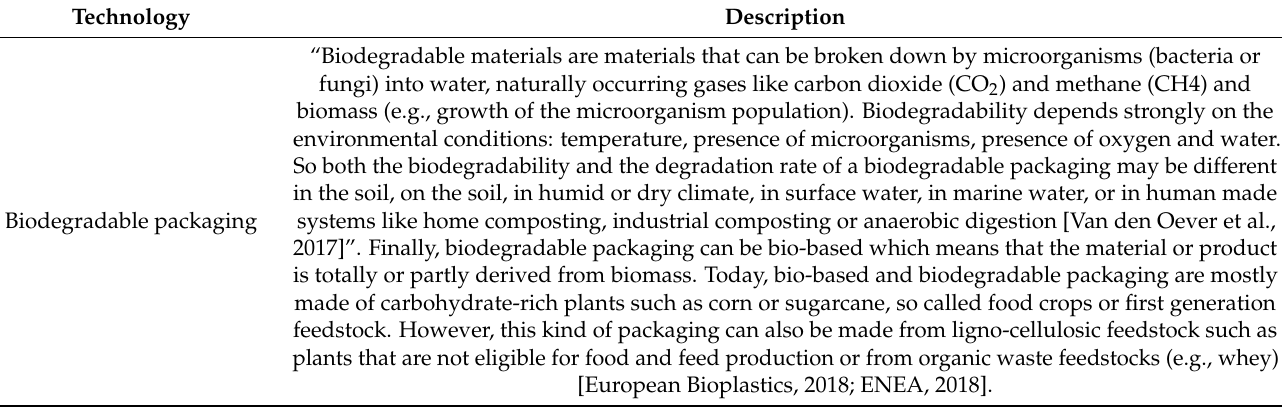
Table A1. General information about biodegradable